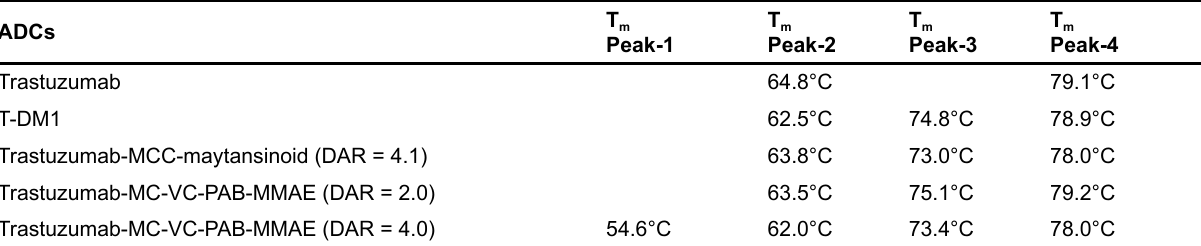
Table 4. Temperature fit parameters of the ADCs ADCs